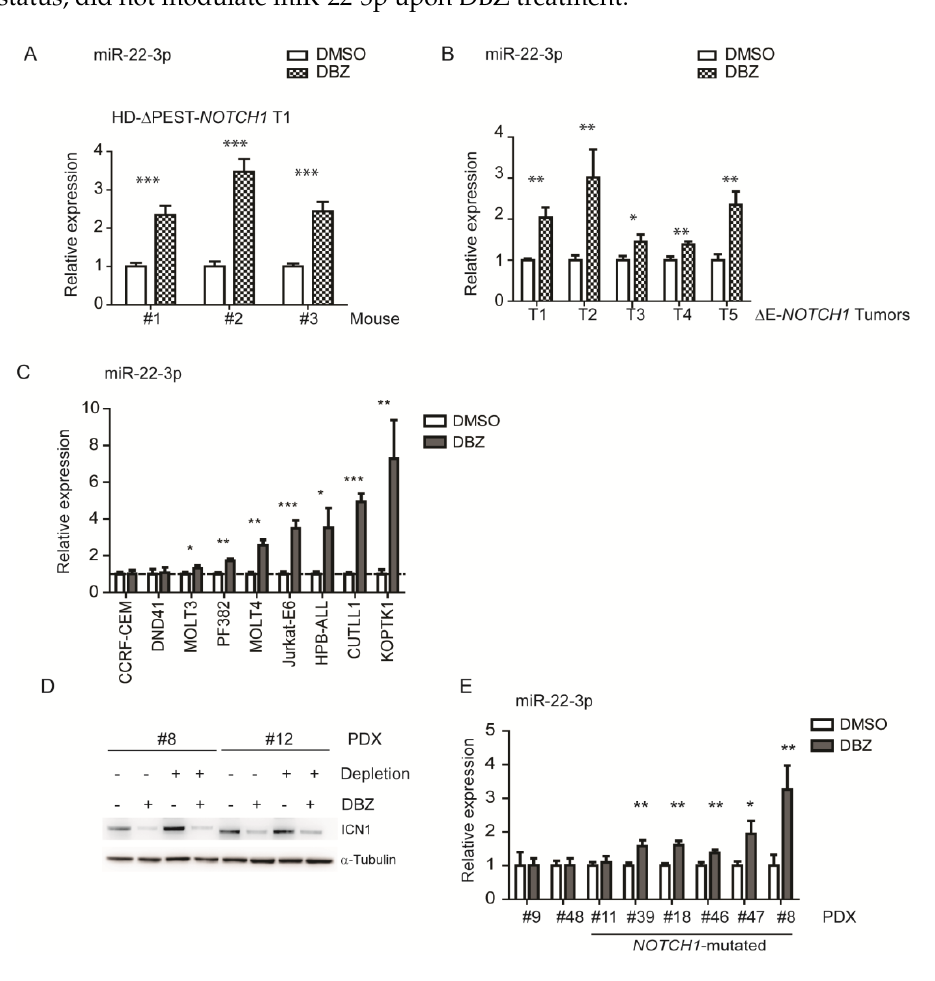
Figure 2. Anti-NOTCH1 treatment in murine and human T-ALL cells results in miR-22-3p upregulation. ( A , B ) qPCR analysis of miR-22-3p expression upon DBZ treatment in murine models of NOTCH1-induced T-ALLs: ( A ) leukemic cells obtained from three mice transplanted with the HD- ∆ PEST- NOTCH1 -tumor-1 (T1), treated in vivo with DMSO or DBZ, were analyzed; ( B ) five independent ∆ E- NOTCH1 -tumors (T1-5), treated in vivo with DMSO or DBZ, were analyzed. ( C ) qPCR analysis of miR-22-3p expression upon DBZ treatment of T-ALL cell lines (treated in vitro with DBZ for 72 h). ( D ) Western blot analysis of intracellular cleaved NOTCH1 (ICN1) in PDX samples treated in vivo with vehicle only (DMSO) or with 5 mg / kg DBZ, both pre- and post-depletion. α -Tubulin was used as loading control. ( E ) The depleted PDX samples were analyzed by qPCR for miR-22-3p expression. Data are represented as mean ± SD. Assays were performed in triplicate (* p < 0.05, ** p < 0.01, and *** p <